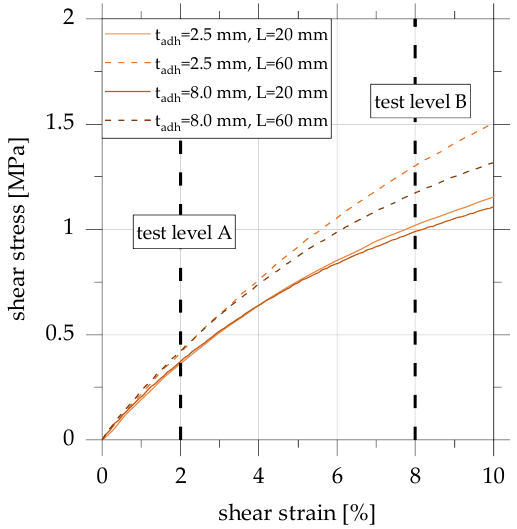
Figure 5. Shear stress – shear strain diagram of quasi-static tensile tests on overlap joints in accordance with [22].